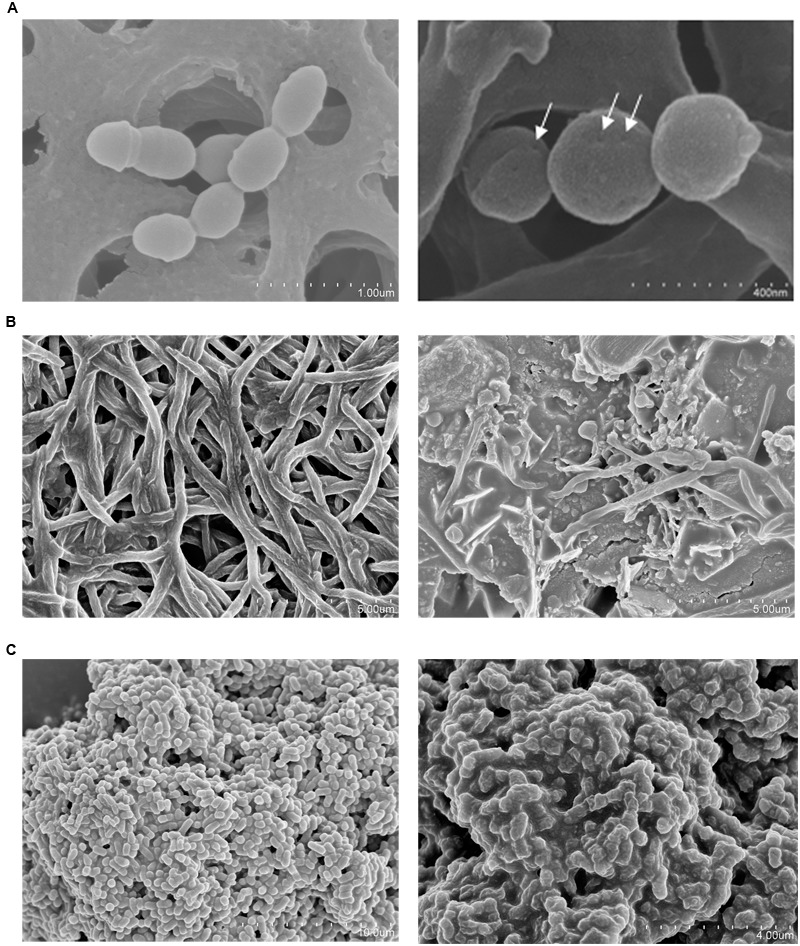
Scanning electron microscopy (SEM) of three oral pathogens before (left) and after (right) a 30-min treatment with 10-fold concentrated supernatant of S. dentisani strain 7746. (A)
Streptococcus mutans (pores are pointed with arrows). (B)
Fusobacterium nucleatum. (C)
Prevotella intermedia.